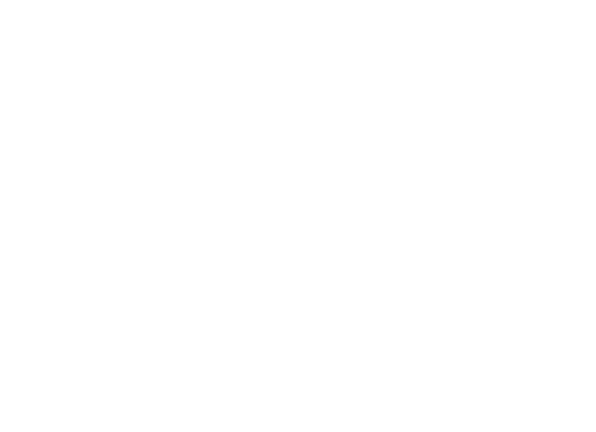
Figure 1. Distribution of sex in biliary and non-biliary